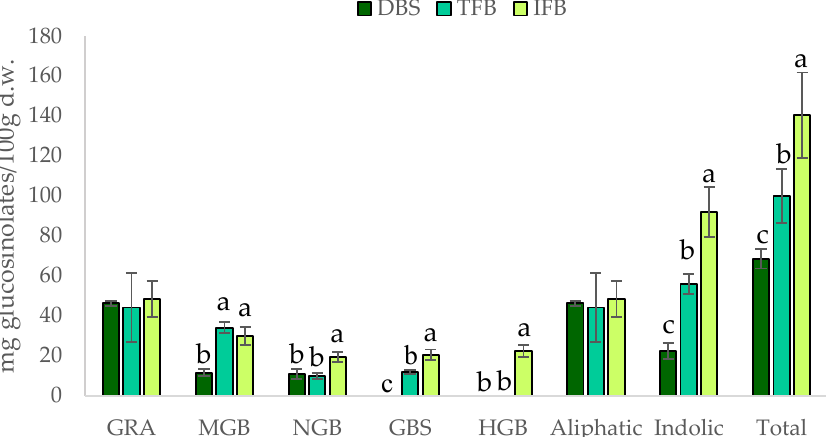
Figure 2. Contents of glucosinolates (mg/100 g of d.w.), analysed by HPLC-DAD, of freeze-dried broccoli stalk ( ■ DBS), the total fibre fraction ( ■ TF B ) and the insoluble fibre fraction ( ■ IF B ). Glucosinolates are presented as individual compounds (GRA: glucoraphanin (4-methylsulphinybutyl-gls), MGB: 4-methoxyglucobrassicin (4-methoxy-3-indolylmethyl-gls), NGB: neoglucobrassicin (1-methoxy-3-indolylmethyl-gls), GBS: glucobrassicin (3-indolylmethyl-gls), HGB: 4-hydroxyglucobrassicin (4-hydroxy-3-indolylmethyl-gls)). Values are expressed as mean ± SD (n = 3). Different letters (a–c) indicate significant differences ( p < 0.05) among the samples for each individual glucosinolate and the total glucosinolates.